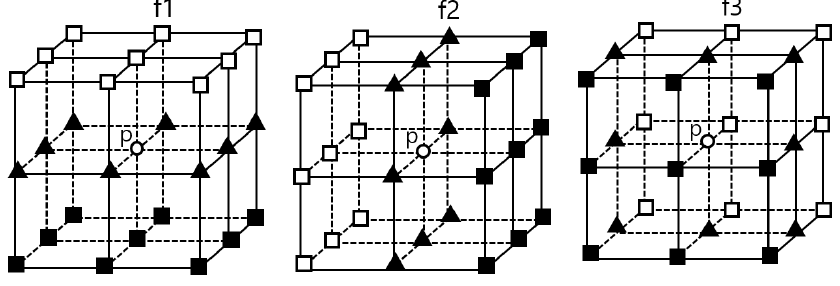
Figure 10. Correcting templates of class F.